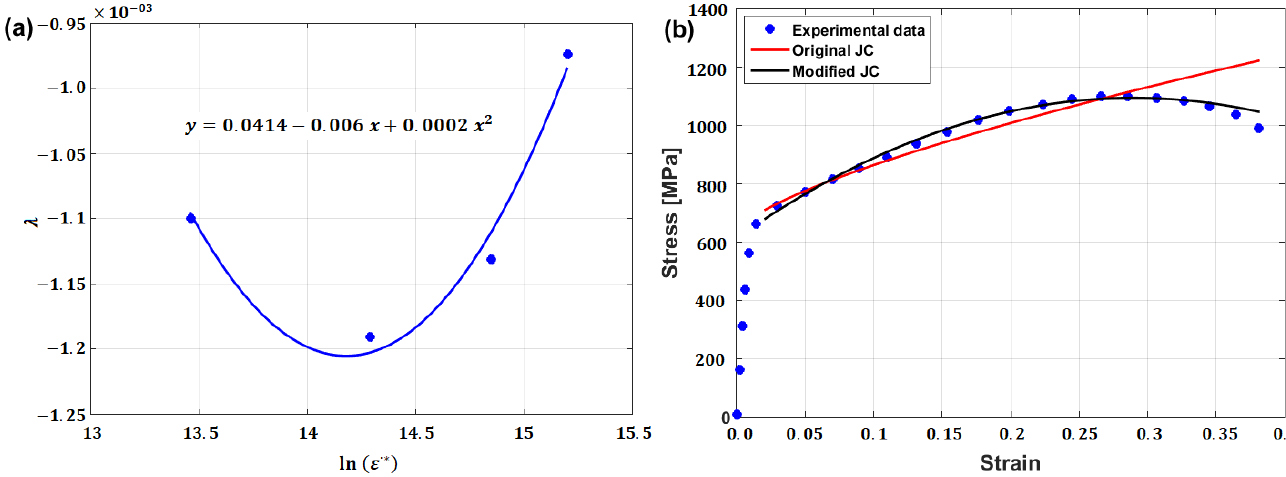
Figure 48. ( a ) Quadratic fitting of parameter λ with ln ( ε ·∗ ) to obtain constants λ 1 , λ 2 , and λ 3 and ( b ) comparison between experimental stresses (markers) and predicted stresses (dashed lines) for TA23 titanium alloy obtained by the original JC model and the modified JC model that was introduced by Yu et al. [60].